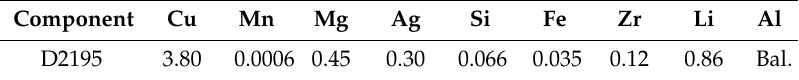
Table 1. Chemical composition of D2195 (wt.%).